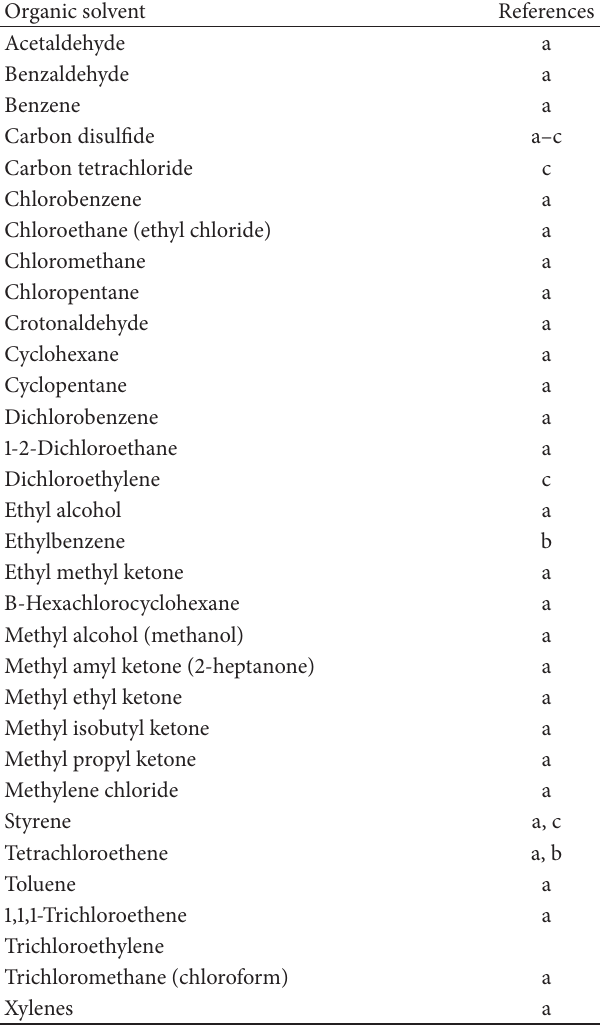
Table 1: Organic solvents detected in human milk. Organic